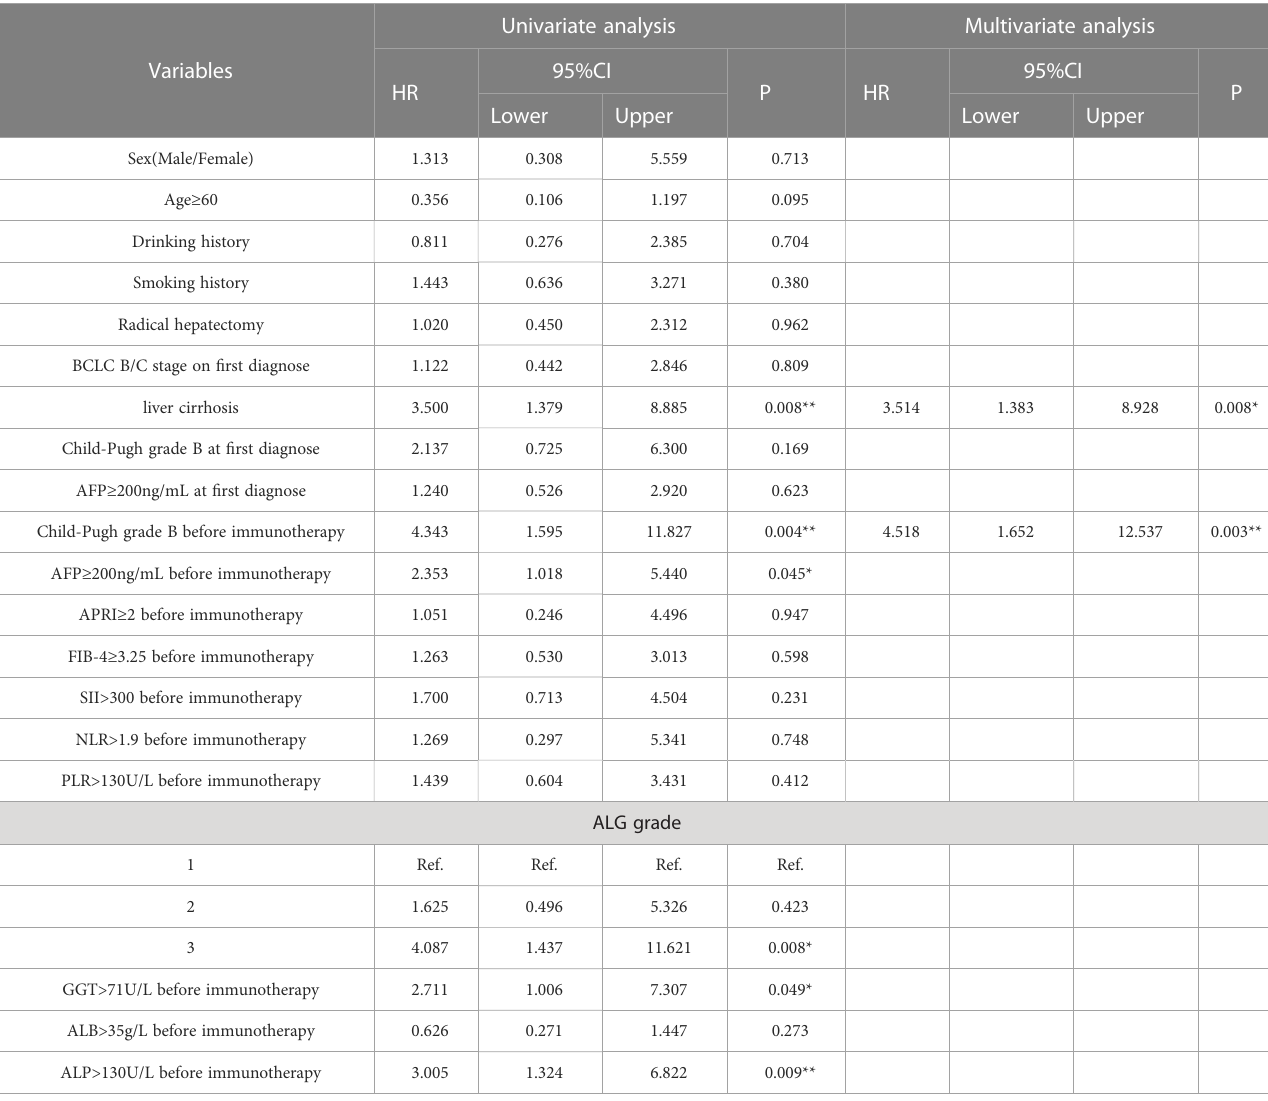
TABLE 4 Cox regression analysis of Overall survival for patients receiving